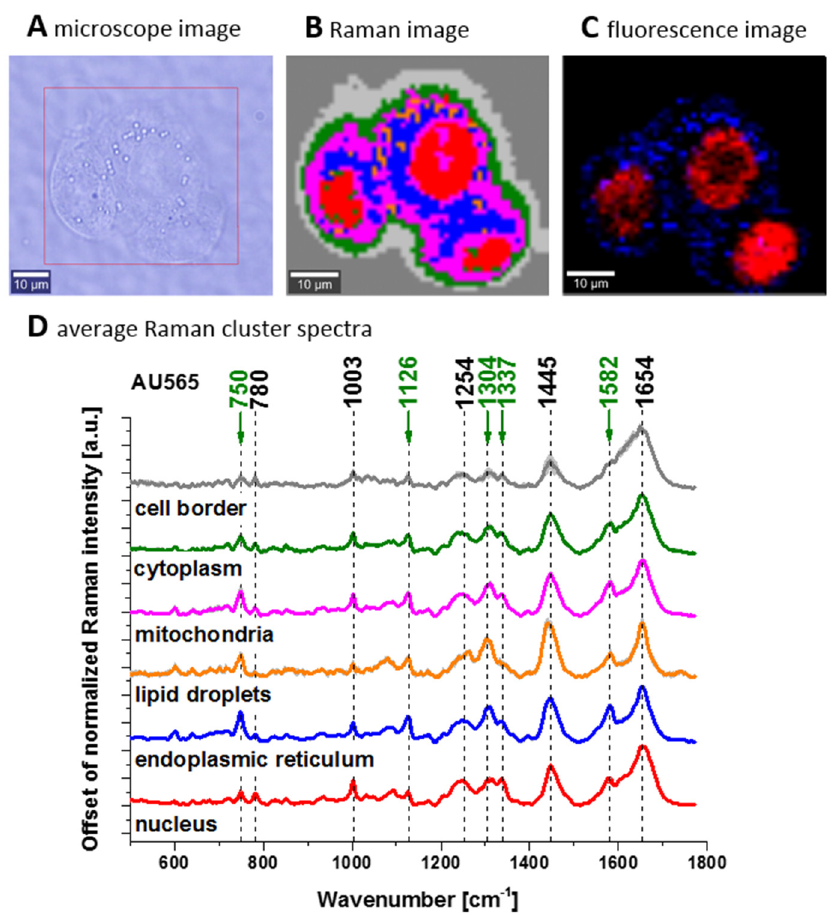
Figure 4. Confocal Raman spectroscopy analysis of the human adenocarcinoma cell line (invasive ductal cancer (AU565)) at the 532 nm wavelength excitation. ( A ) Microscopy image, ( B ) Raman image from the cluster analysis (nucleus (red), endoplasmic reticulum (blue), lipid droplets (orange) cytoplasm (green), mitochondria (magenta), cell border (light grey), area out of the cell (dark grey), image size: 55 µ m × 50 µ m, resolution of 1 µ m, laser excitation 532 nm, power 10 mW, integration time 0.3 s), ( C ) fluorescence image of lipids (blue, Oil Red O staining) and nucleus (red, Hoechst 33342 staining). ( D ) Average Raman cluster spectra for the number of cells, n = 20 (8639 spectra were recorded (n(nucleus) = 2142, n(endoplasmic reticulum) = 1530, n(lipid droplets) = 121, n(cytoplasm) = 1464, n(mitochondria) = 1689, n(cell border) =